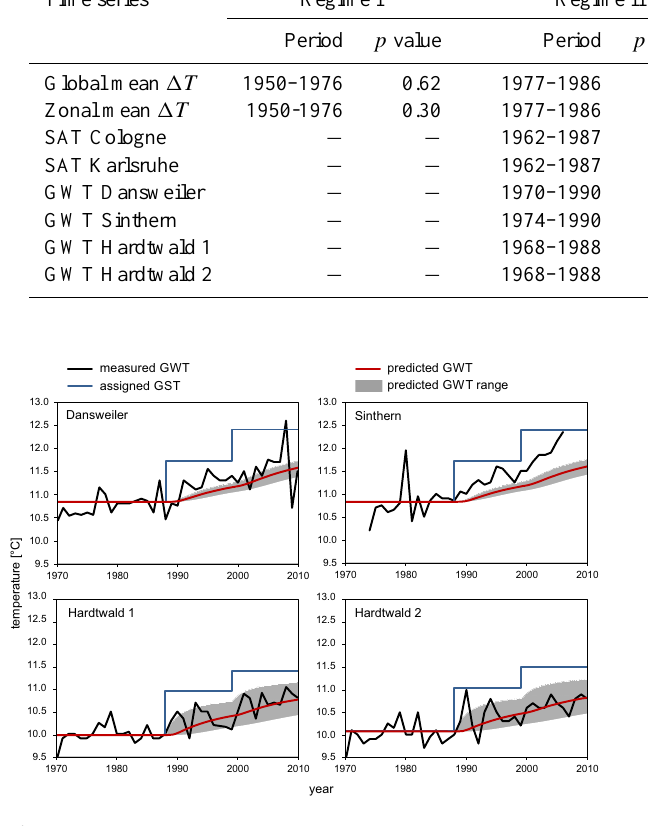
Figure 4. Measured GWT, predicted GWT, and assigned GST boundary conditions for the TCA model (Eq. 6) for each well versus the year. Red lines indicate GWT results obtained using the mean well screen depth, thermal properties and recharge rates presented in Tables 2 and 3. The GWT data at the lower and higher ends of the temperature envelope are obtained with the ranges in well screen depth, thermal diffusivity, heat capacity, and recharge rates (Tables 2 and